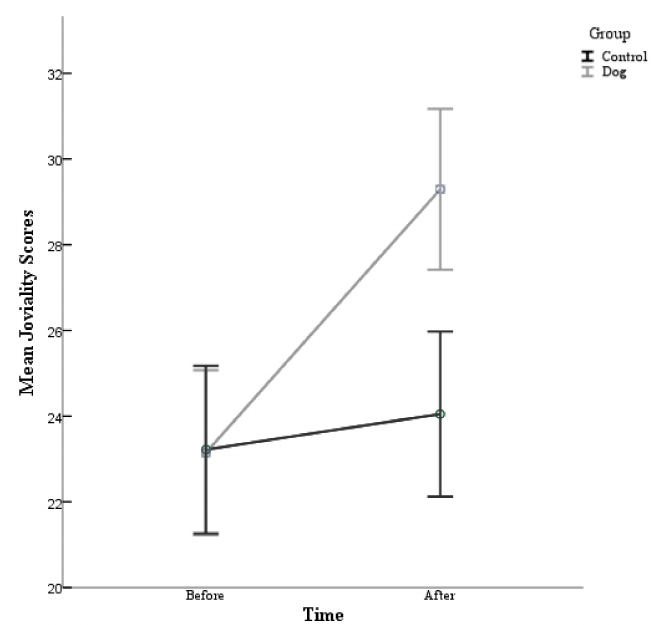
Figure 5. The mean joviality scores are plotted for the participants in the control condition and the participants in the experimental (dog) condition before their interaction and after their interaction with 95%-confidence-interval error bars.